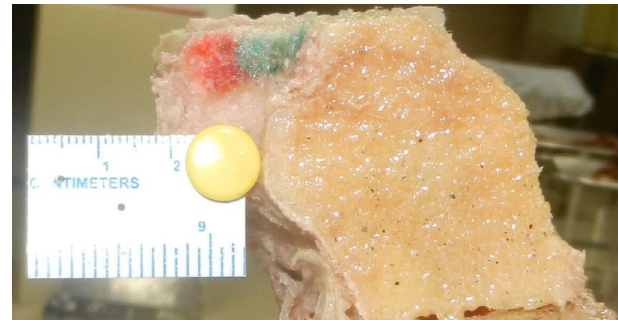
Figure 5. Footprint of PCL on femur after bone resection. Antero-lateral bundle is marked with green and postero-medial bundle with